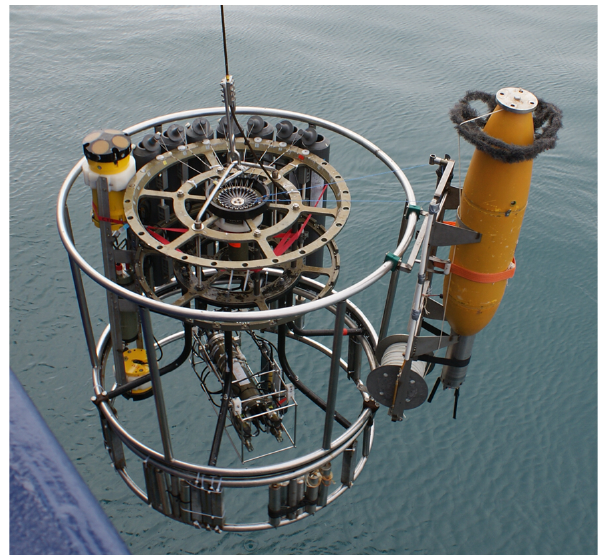
Fig. 1. Photograph of the deployed system. The MSP is the light- colored object on the right. Also shown are the Rosette water sam- ples, the RDI LADCP, and the SBE CTDO.